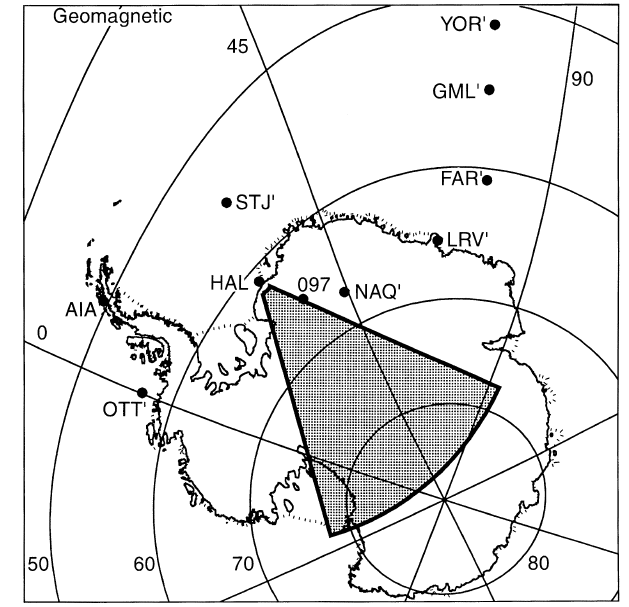
Fig. 1. A map of the Southern Hemisphere polar region overlaid with the PACE geomagnetic co-ordinate grid (Baker and Wing, 1989) showing the field of view of the Halley HF radar ( grey shaded area ), magnetometer stations in the Southern Hemisphere ( HAL, AIA ), magnetometer stations mapped from the Northern Hemisphere ( OTT ¢ , STJ ¢ , NAQ ¢ , LRV ¢ , FAR ¢ , GML ¢ , YOR ¢ ) and the magnetic footprint of LANL spacecraft 1987–097 (097). The latter is mapped from geostationary orbit using the Tsyganenko (1987) field model for the lowest